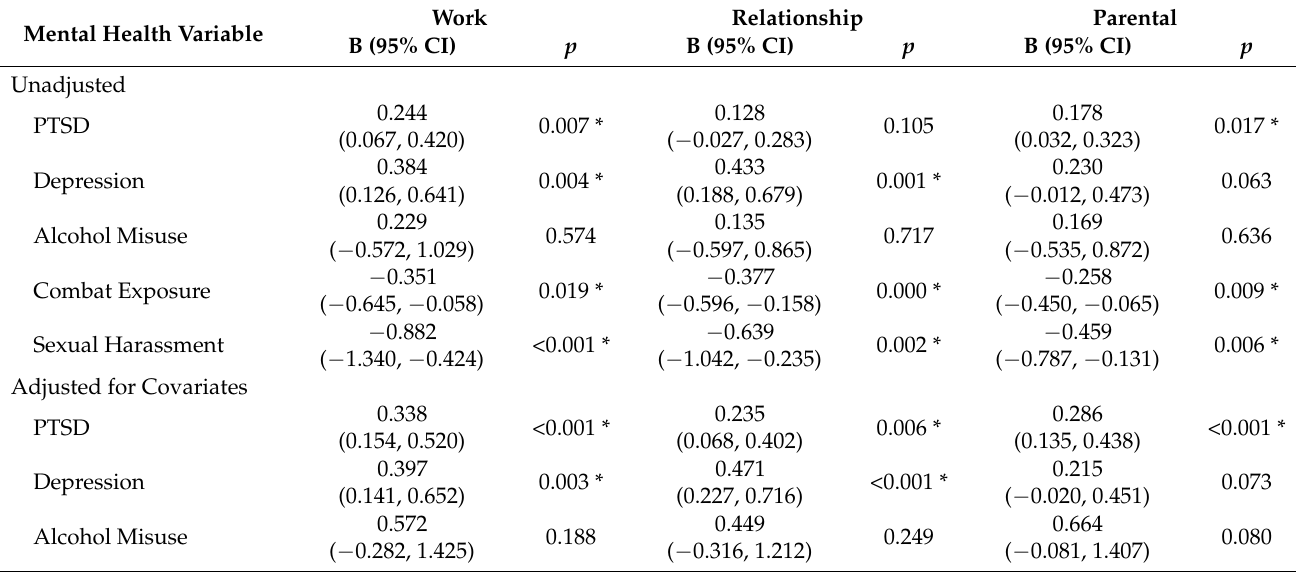
Table 1. Effects of deployment stressors and T1 to T2 changes in mental health symptom severity on T2 to T3 psychosocial functioning.